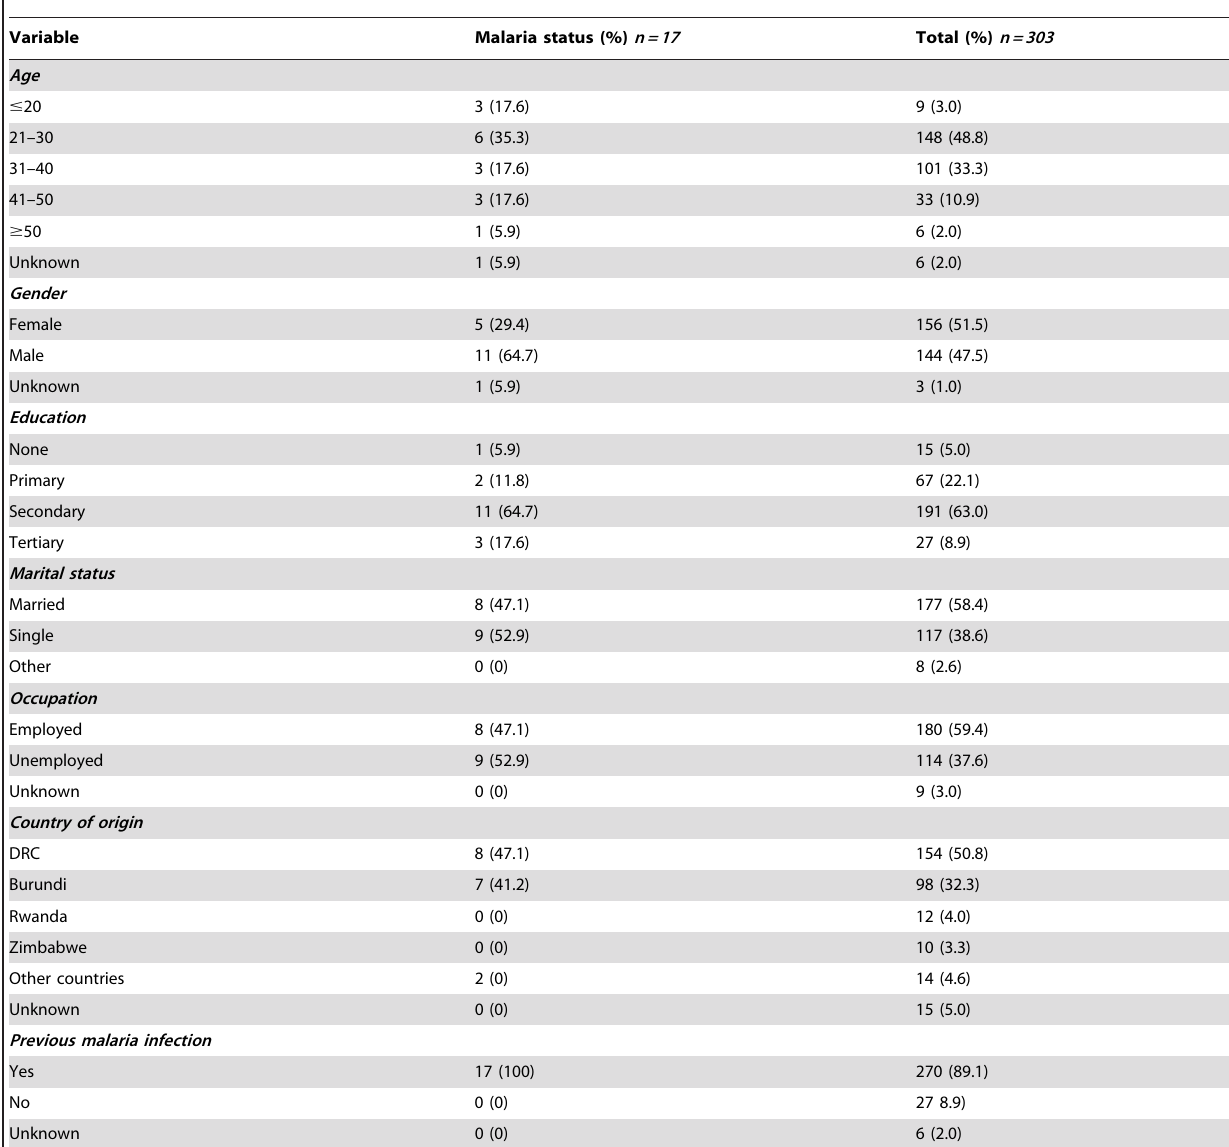
Table 1. Malaria infection and participants